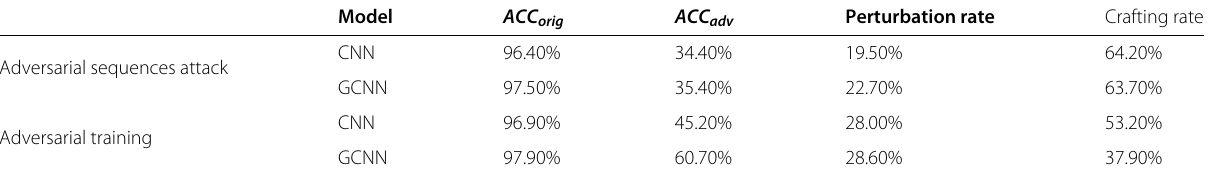
Table 8 Comparison between models with adversarial training and models without adversarial